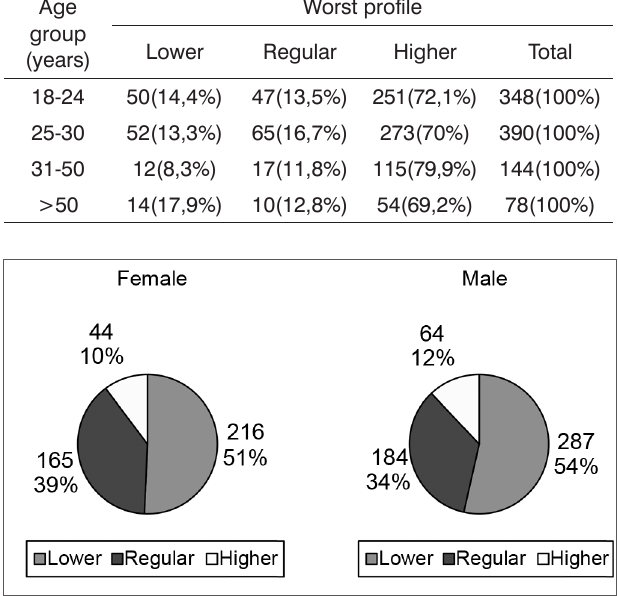
Chart 3. Best profiles according to the sex of interviewees.